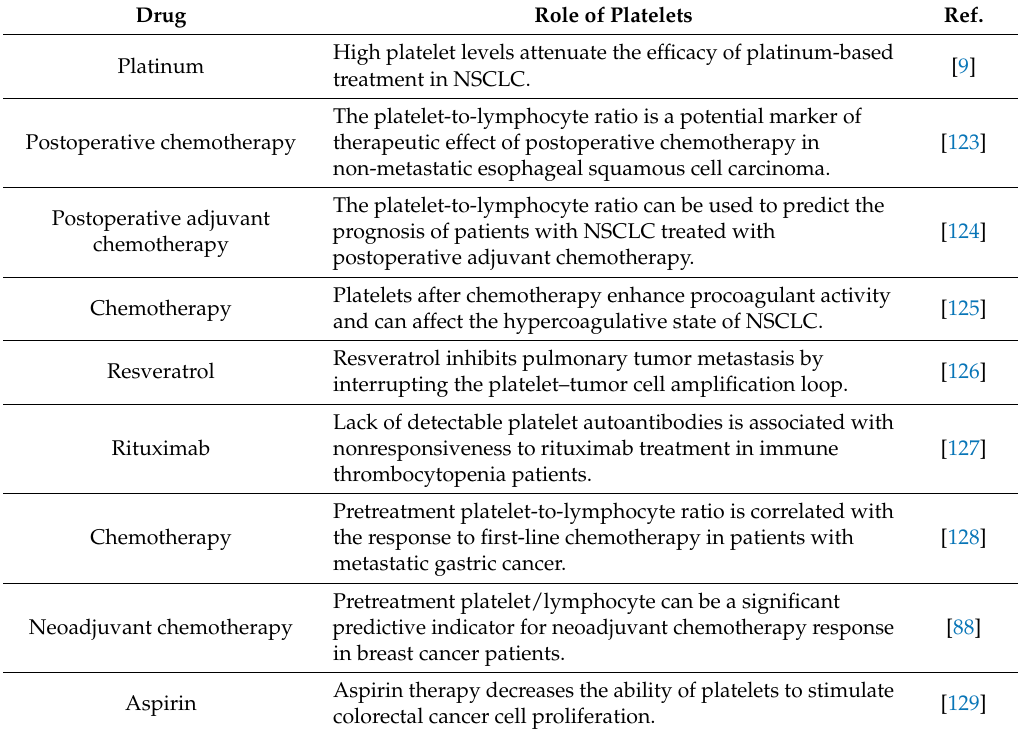
Table 1. The contributions of platelets to chemotherapy treatment in cancer cells.